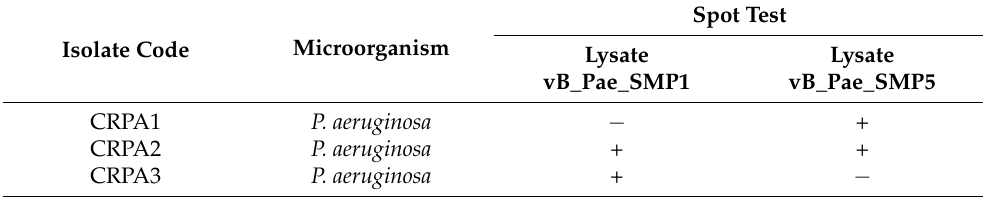
Table 2. Host range of the lytic properties of phages vB_Pae_SMP1 and